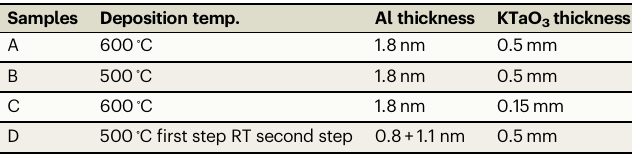
Table 1 | Growth parameters of the different samples used in this study Samples Deposition